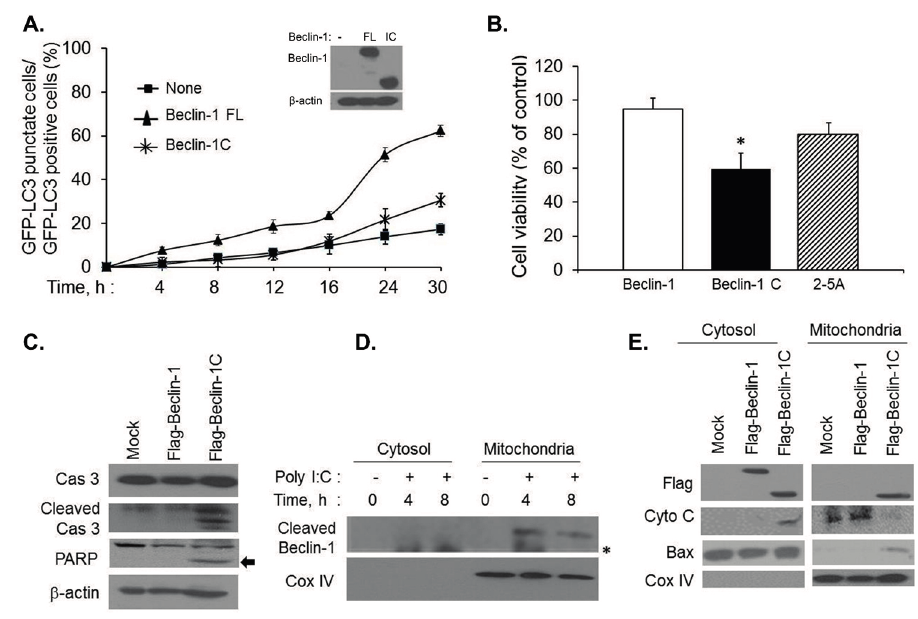
Figure 5. Beclin-1C fragment produced by caspase 3 activity translocates to the mitochondria and enhances apoptosis. ( A ) HT1080 cells were transfected with siRNAs to knock down endogenous Beclin-1 followed by expression of Flag vector (mock), Flag-Beclin-1 (full-length, 1–450) or Flag-Beclin 1C (aa150–450) along with GFP-LC3 plasmid. After 24 h, cells were transfected with 2–5A (10 µM) for indicated times and the percentage of GFP + cells showing puncta formation compared to mock treated cells was analyzed. Immunoblot shows expression of Beclin-1 constructs in knock down cells. Results shown represent mean ± SEM for three experiments and at least 100 cells were analyzed per assay; ( B ) HT1080 cells were transfected with Flag vector (mock), Flag-Beclin-1 (full-length, 1–450) or Flag-Beclin 1C (aa150–450) for 24 h and cell viability was compared to cells transfected with 2–5A (10 µM) for 24 h by MTT assay. Student’s t test was used to determine p values of cells expressing Beclin-1C and compared to cells expressing Beclin-1 three independent experiments performed in triplicate ± SD. ( C ) HT1080 cells were